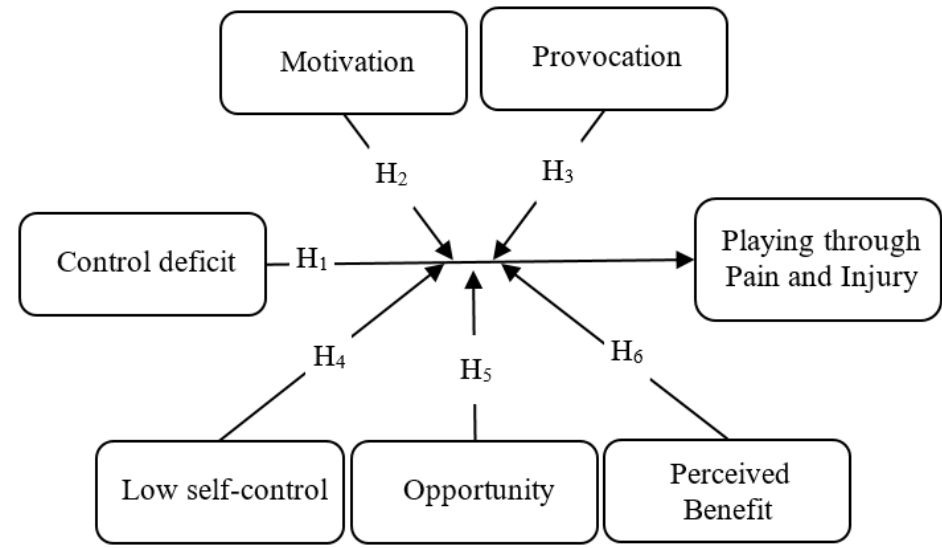
Figure 1. The conceptual model of the relationship between control balance and playing through pain and injury.